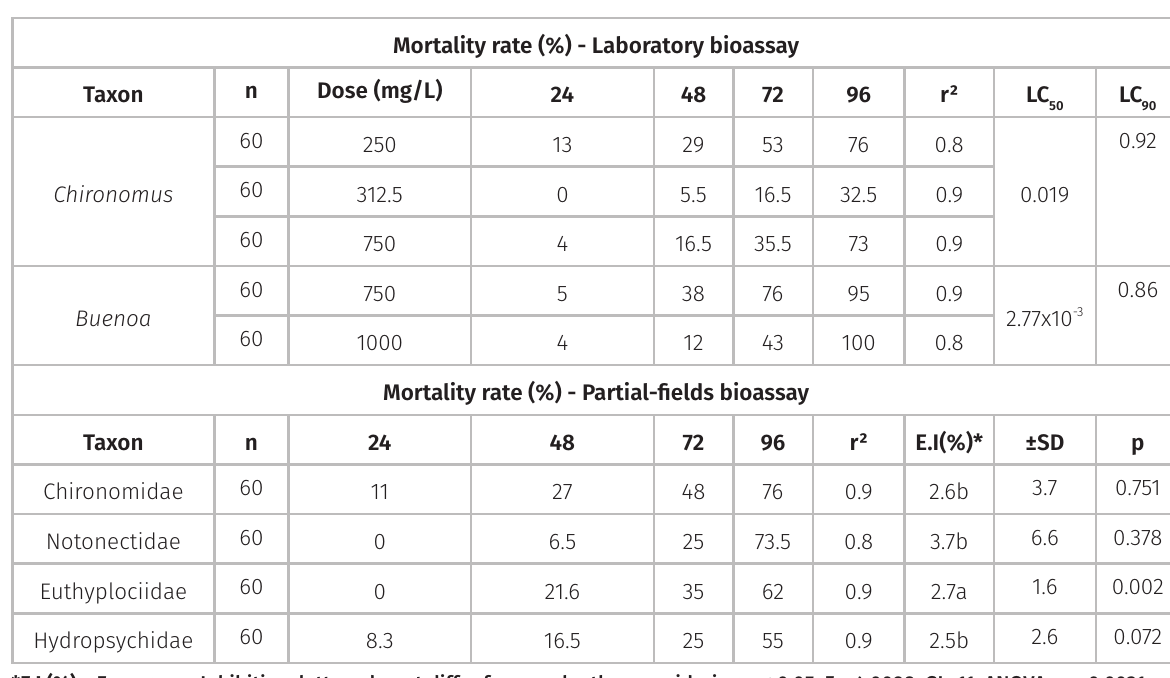
Table I. Mortality rate (%) of the groups submitted to laboratory and partial-field bioassays, with readings performed up to 96 hours after application (dose - mg/L; CL - g/L).